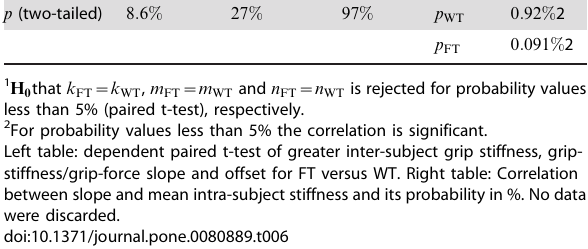
stiffness/grip-force slope and offset for FT versus WT. Right table: Correlation between slope and mean intra-subject stiffness and its probability in %. No data were discarded.